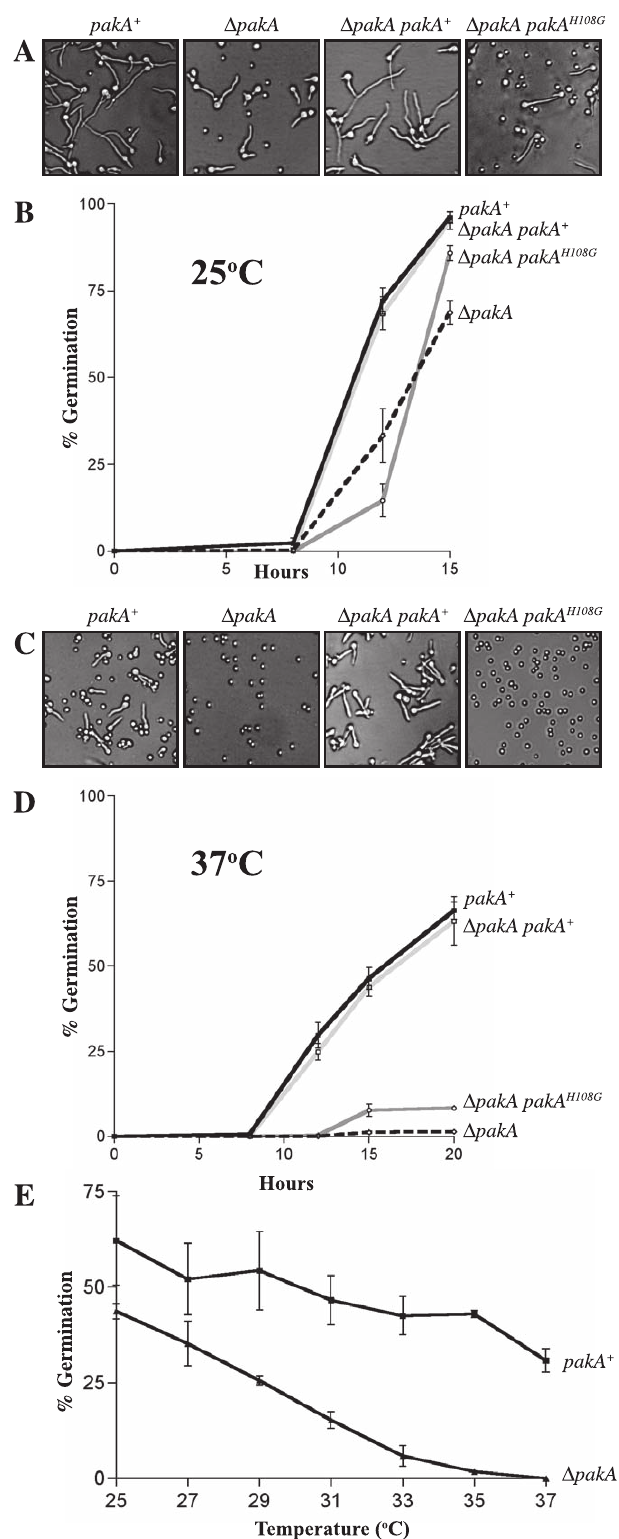
Figure 3. Mutationof pakA Affects Conidial Germination at 25 8 C and37 8 C (A) Conidia from the wild-type ( pakA þ ), D pakA , D pakA pakA þ , and D pakA pakA H108G strains were grown in liquid medium for 12 h at 25 8 C (A) or 37 8 C (C). The percentage of germinated conidia was measured after 8, 12, or 15 h incubation at 25 8 C (B) or after 8, 12, 15, and 20 h at 37 8 C (D). One representative strain of each genotype is shown. Three independent experiments were performed and standard error of the mean bars